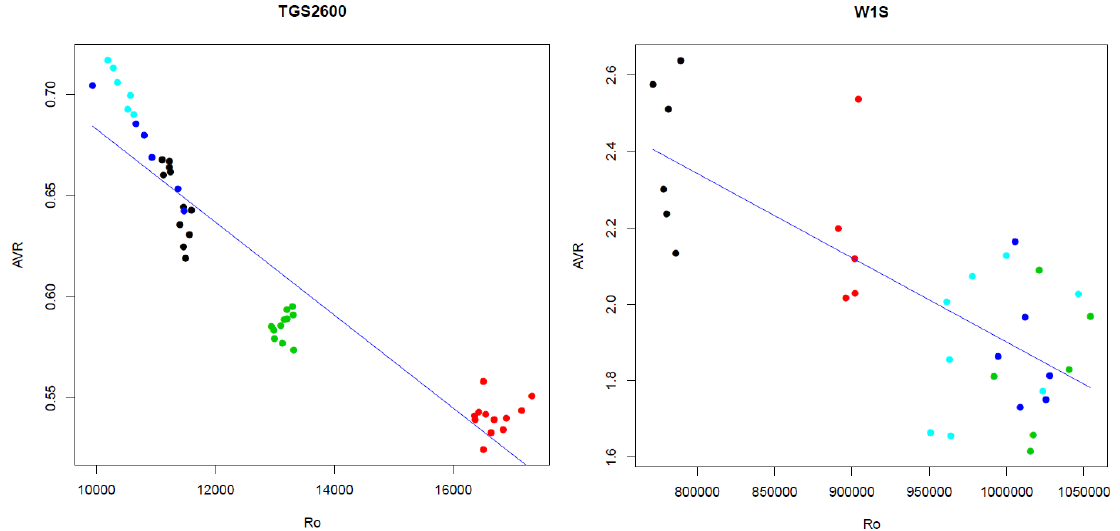
Figure 7. Dependence of AVR, calculated over the sensor curves of the Figure 5, on the values of R . o